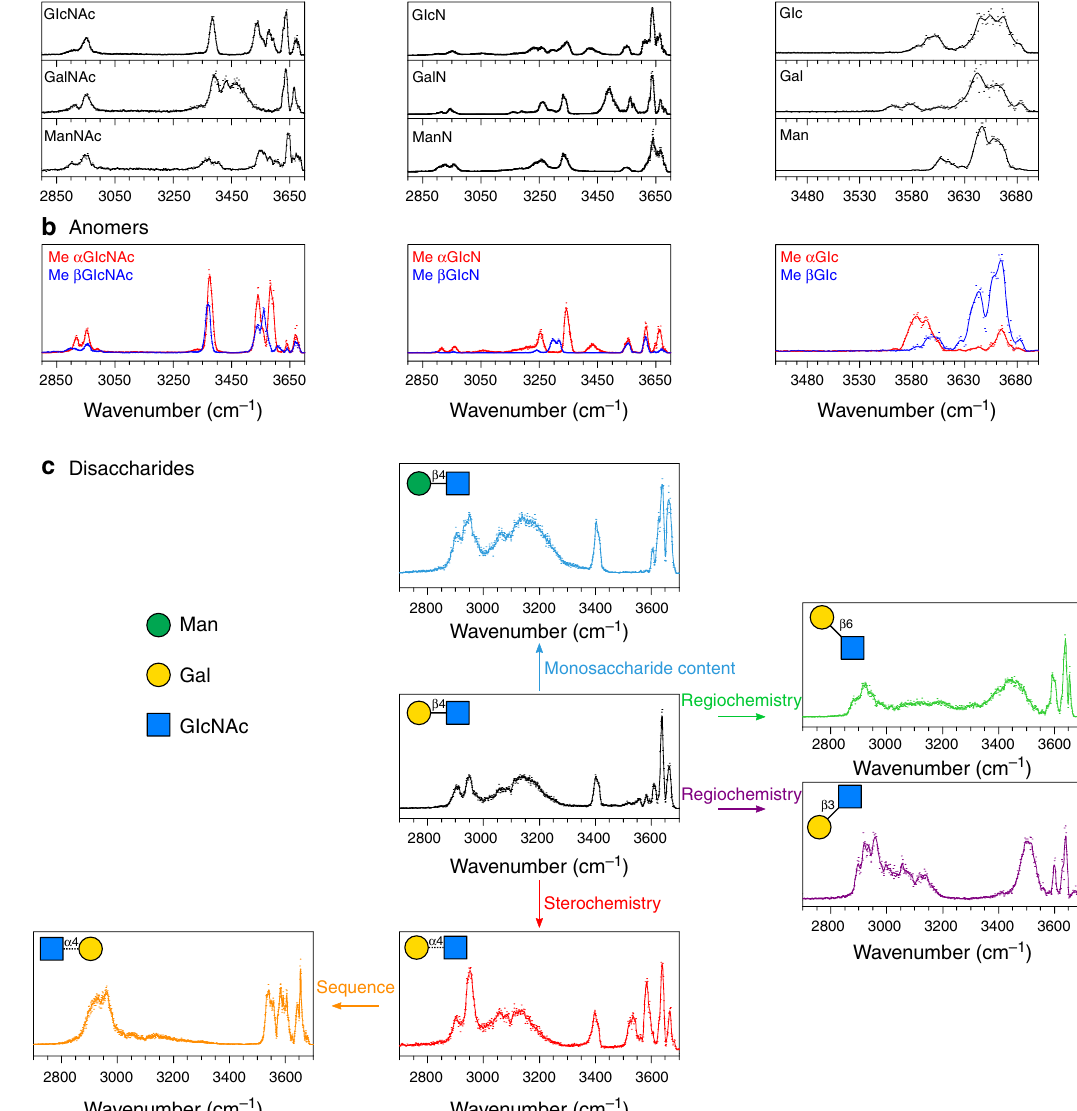
Fig. 1 IRMPD signatures of monosaccharide and disaccharide standards. a N -acetylhexosamines, hexosamines and hexoses. b Individual methyl-blocked anomers of N -acetylglucosamine, glucosamine and glucose. c Isomers of GalGlcNAc: Gal β 1,4GlcNAc (black); Man β 1,4GlcNAc (blue); Gal β 1,3GlcNAc (purple); Gal β 1,6GlcNAc (green); Gal α 1,4GlcNAc (red); GlcNAc α 1,4 Gal (yellow). Symbols from ref.